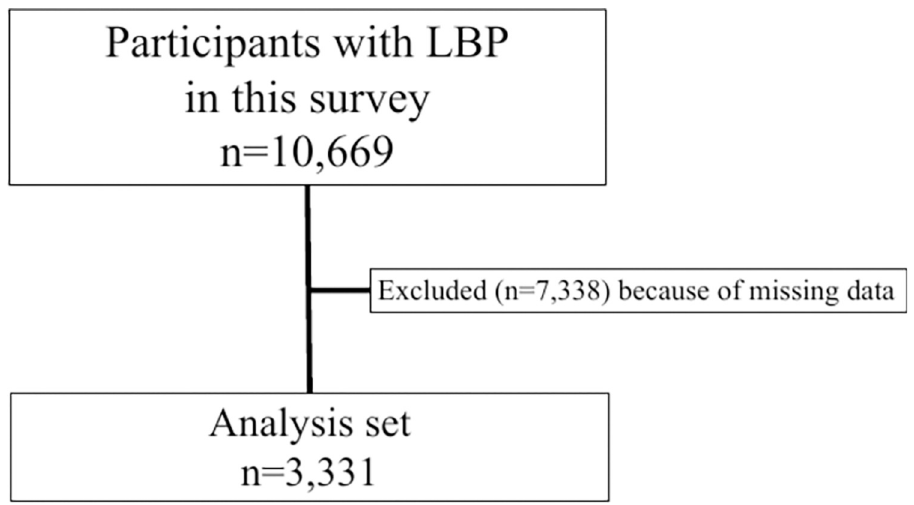
Fig 1. Flow chart of participant inclusion. LBP, low back pain.